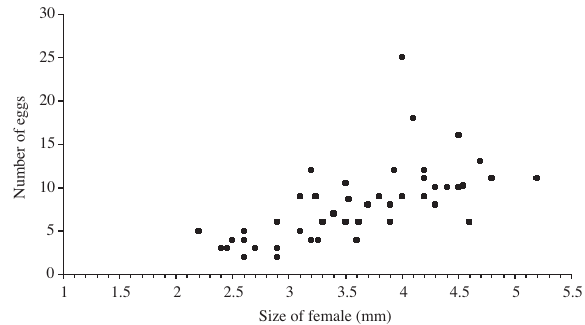
Size of female (mm) F IG . 5. – Dispersion diagram of the number of eggs in relation to the size of the female (mm).